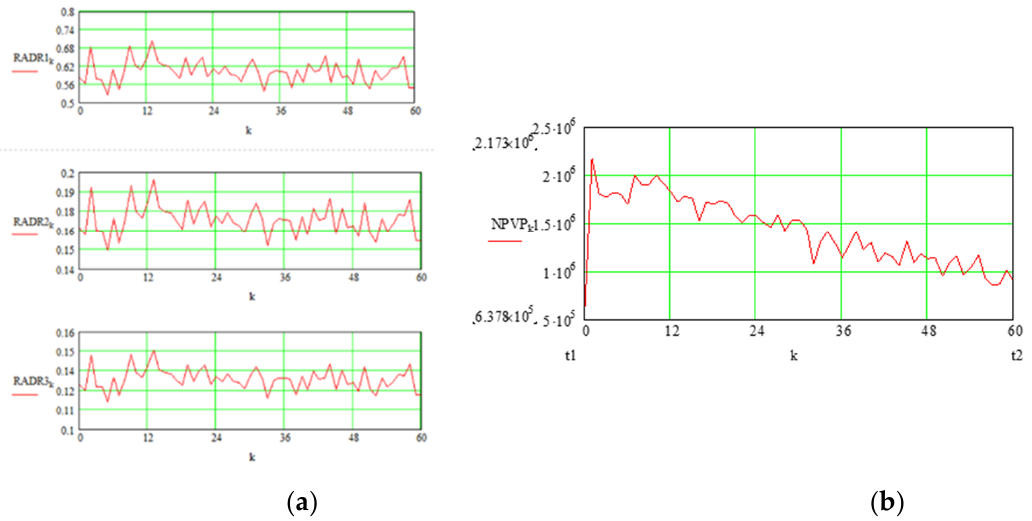
Figure 9. Graphical representation of the RADRs ( a ) and total NPV ( b ) dynamics for Scenario B8 (m = 3, σ = 0.20; term structure of the interest rate not considered; interest rate seasonal rate fluctuations not considered).